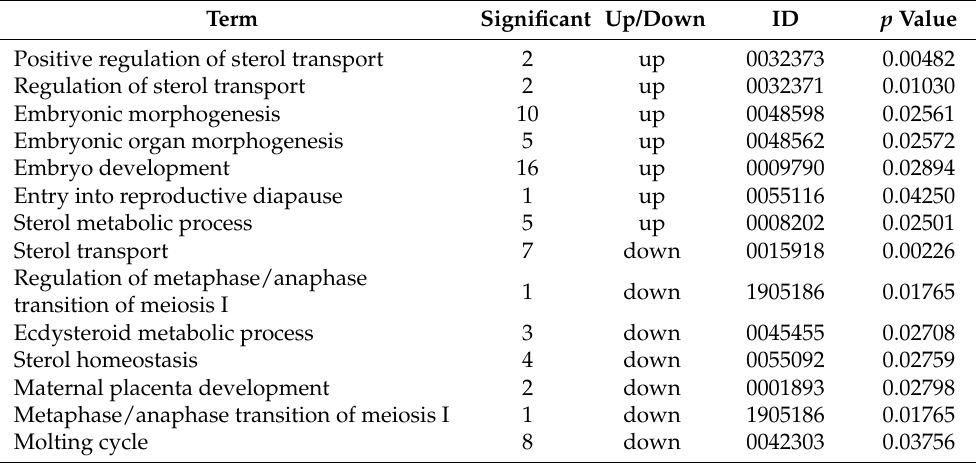
Table 2. The GO term of related to ovarian development in the HC_E vs. CG_E group. Term Significant